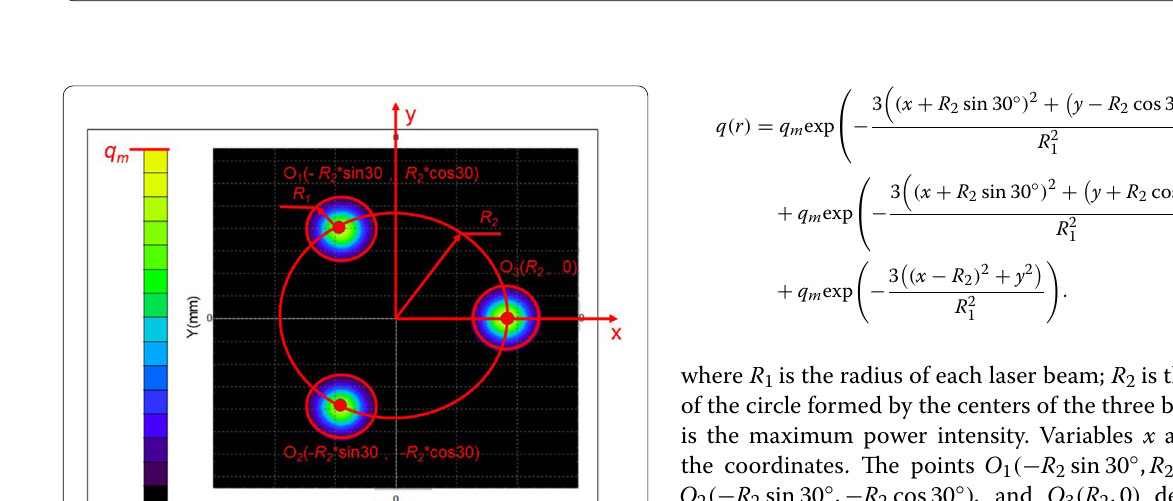
Figure 8 Schematic of three-beam laser simulated by TracePro: a transmission characteristic, b beams at negative defocus, c beams at focal plane, and d beams at positive defocus